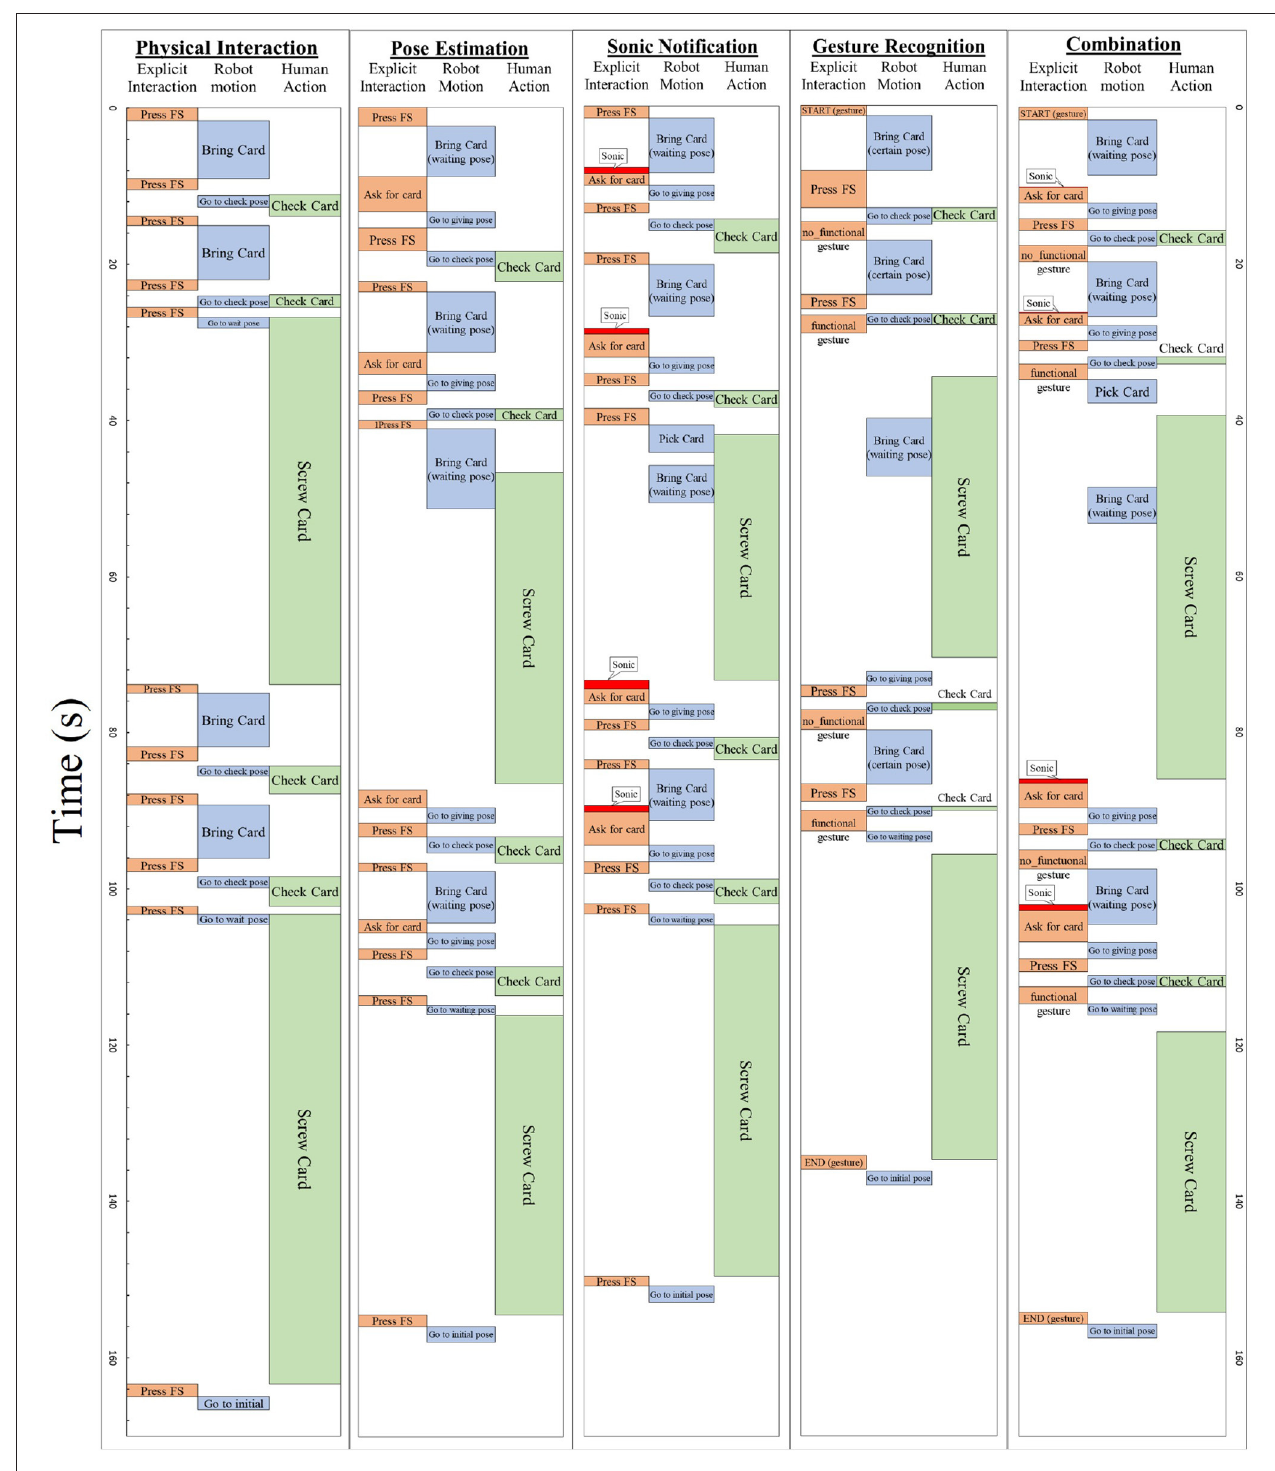
FIGURE 11 | Average timeline of each experiment (Form A). to 2.01 s. Despite the fact that PI seems to display the best response time, in Figure 11 the average cycle time of the experiment “ Physical Interaction ” seems to be greater. This